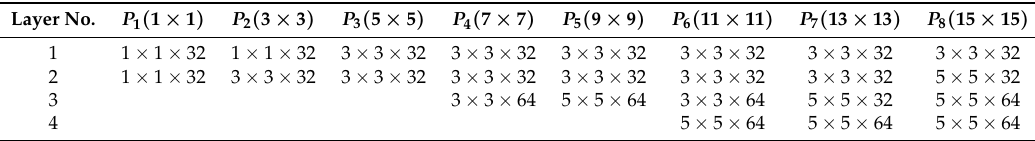
Table 1. The network architectures of multi-scale CNNs. For multi-scale input patches { P s } S various input scales, the detailed structures of each sub-network including the numbers of convolution layers, kernel sizes and kernel numbers are